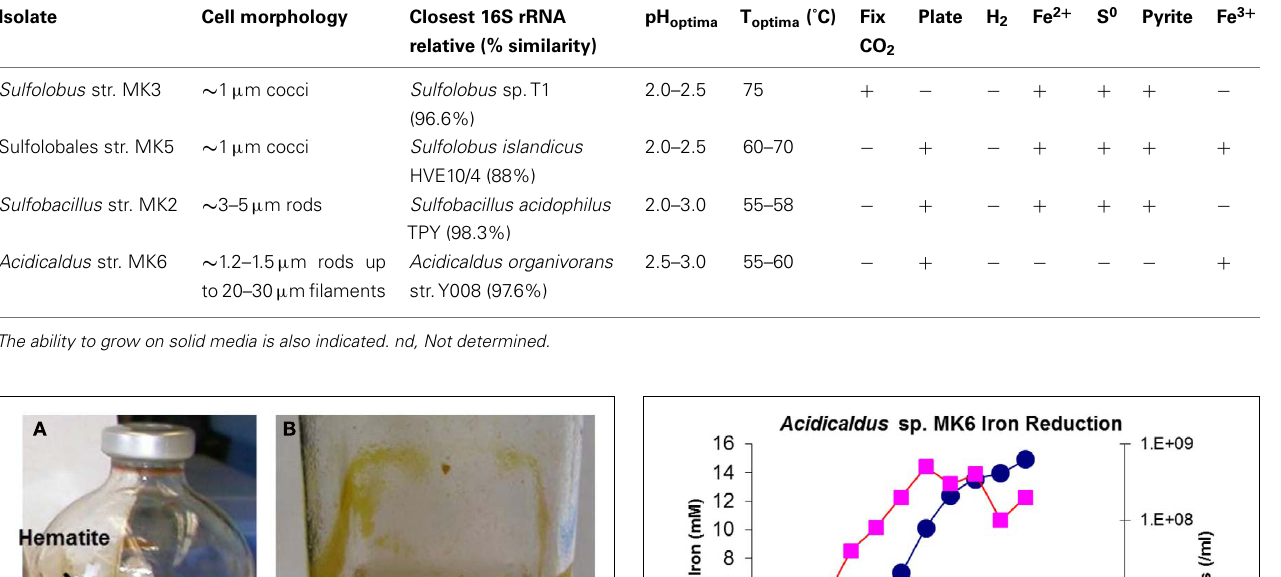
Plate H 2 Fe 2 + S 0 Pyrite Fe 3 + CO 2